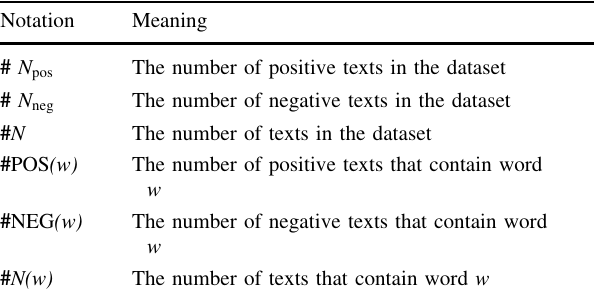
Fig. 3 Illustration of (weighted) text–word pairs counts